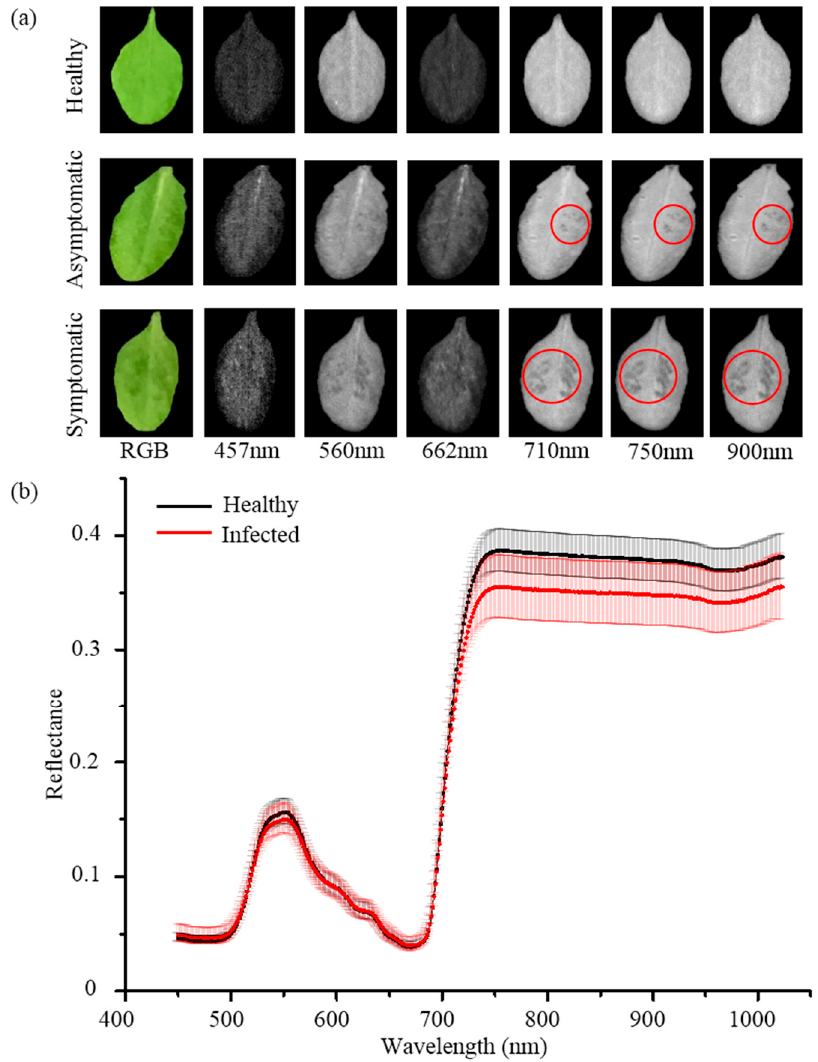
Figure 2. ( a ) The color images and six representative spectral images of the healthy and infected samples (asymptomatic and symptomatic). ( b ) Mean spectra and standard deviations of the healthy ( n = 138) and infected ( n = 147) samples in the range of 450–1023 nm.